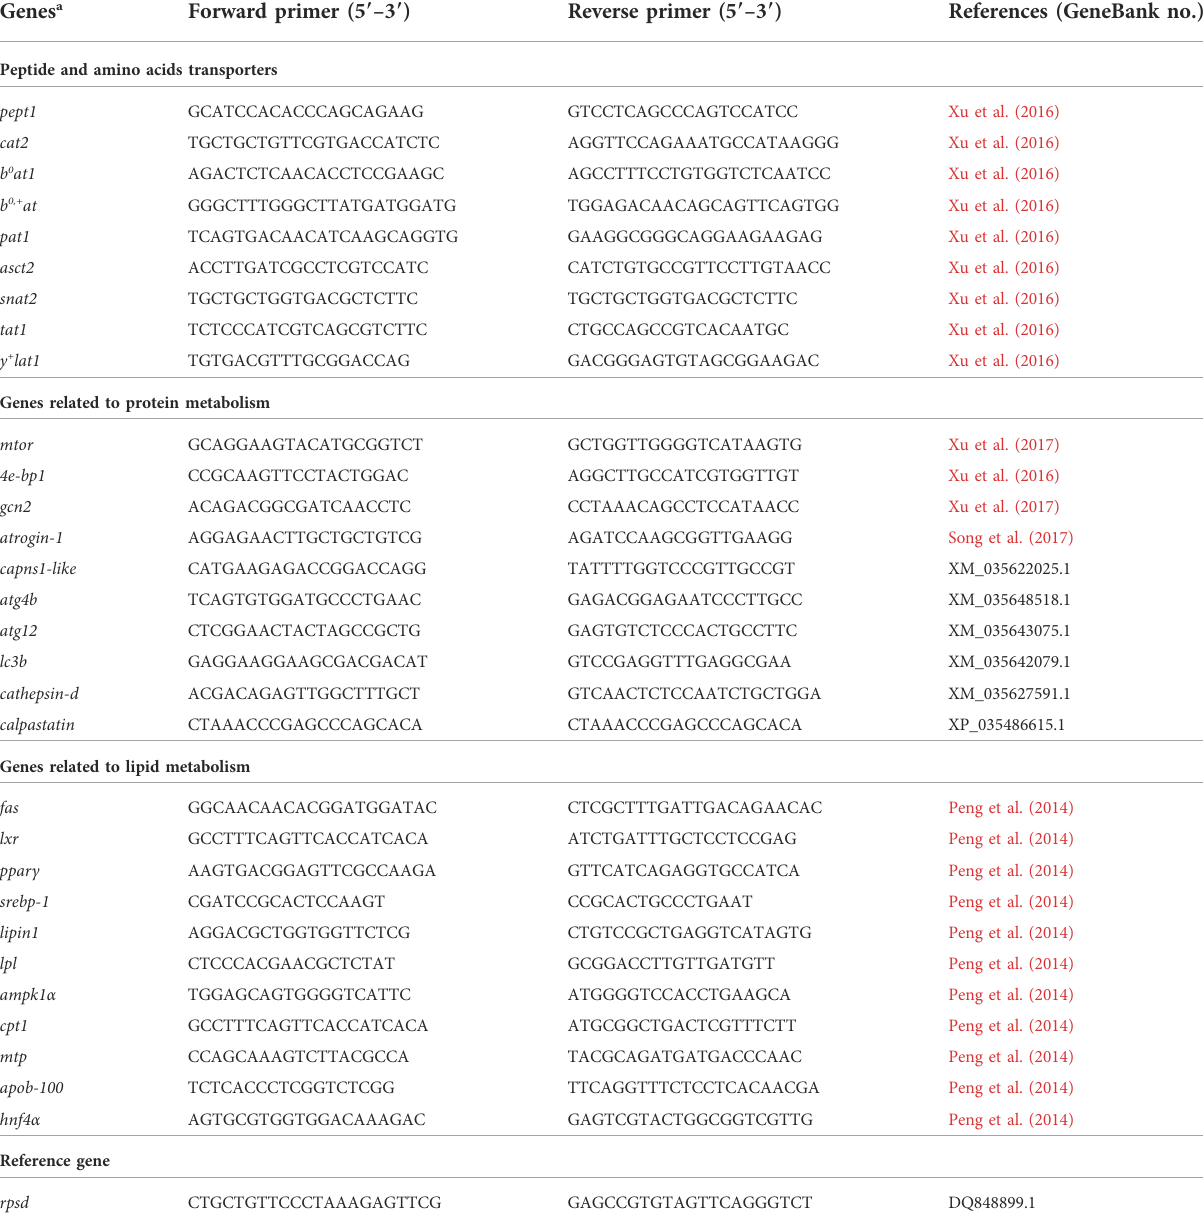
TABLE 3 Primer sequences used for real-time quantitative